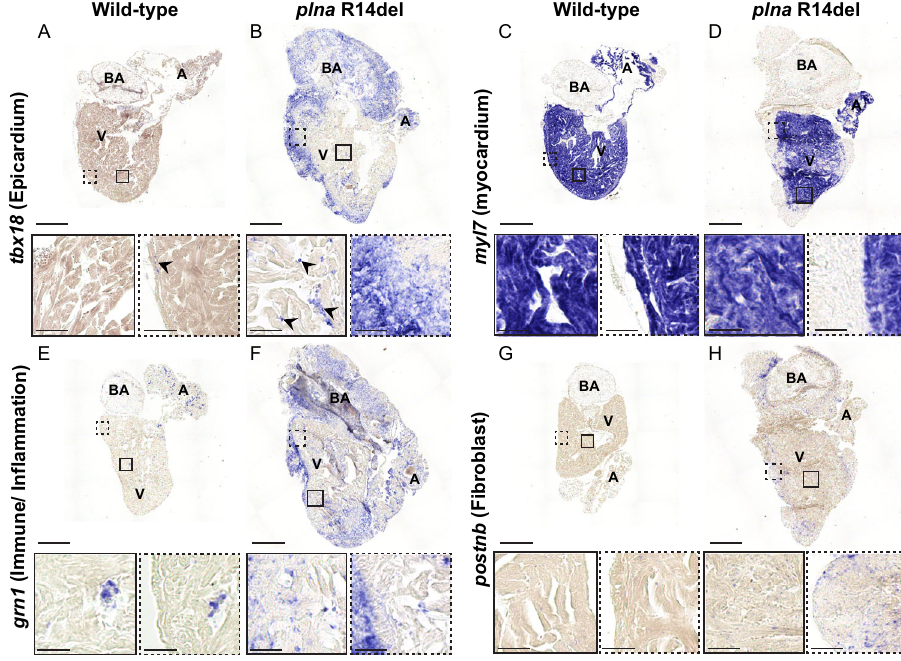
Fig. 2 Epicardial response and immune in fi ltration in adult hearts of plna R14del zebra fi sh. In situ hybridization on wild type and plna R14del mutant adult zebra fi sh hearts, 2 years of age. A , B Expression of tbx18 to indicate the epicardial cells. C , D Expression of myl7 to indicate the myocardial cells. E , F Expression of grn1 to indicate the immune cells. G , H Expression of postnb to indicate fi broblasts. All stainings were performed on WT n = 3, plna R14del n = 3, two experimental replicates. Zoom-in of each region is indicated. Images were taken at a magni fi cation of ×20. Scale bars are 200 µ m for whole- heart tile scans and 50 µ m for zoom-in regions. A atrium, V ventricle, BA bulbus